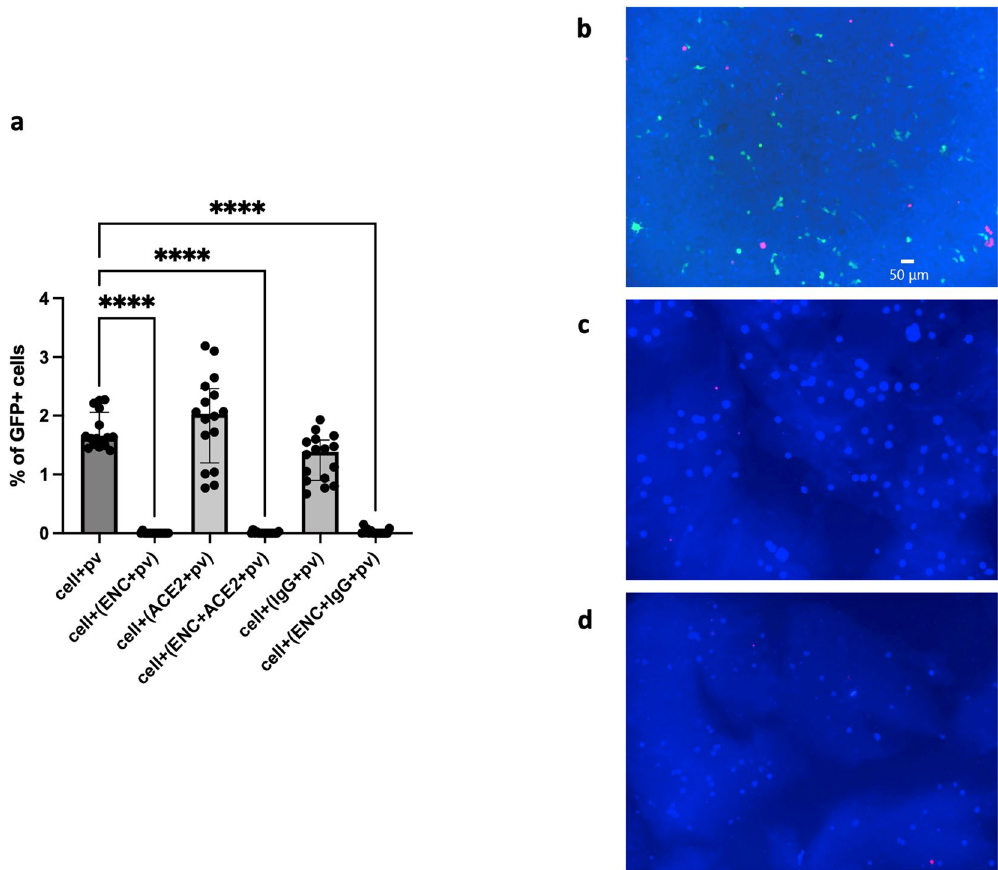
Figure 3. ENC prevented SARS-CoV-2 pseudovirus infection of 293T-hsACE2 cells. 293T-hsACE2 cells were inoculated with SARS-CoV-2 pseudovirus (pv) with a GFP reporter in conditions with and without endospermic nanocellulose (ENC) and molecular lures (ACE2 or anti-SARS-CoV-2 S IgG (IgG)) and incubated for 3 days. ( a ) Cells were harvested for flow cytometry analysis and % of GFP infected cells was determined for each condition (n = 16, **** p < 0.0001, Kruskal–Wallis test, median with interquartile range). Fluorescent microscopy was used to image cells embedded in ENC and challenged with pseudovirus ( b – d ); shown is one representative experiment out of four. ( b ) infected cells in positive controls (cells + pv), ( c ) cells embedded in ENC then infected with pv or ( d ) cells embedded in ENC and infected with pv embedded in ENC. Blue represented all cells (CellTrace™ Violet), green indicated GFP infected cells, and Red indicated propidium idodide for dead cells. The ENC was visible as a faint blue cloud in ( c , d ) and demonstrates that cells are immobilized in the